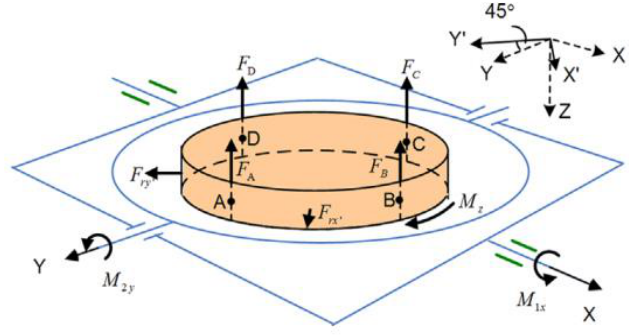
Figure 2. Conceptual drawing of MISP system.